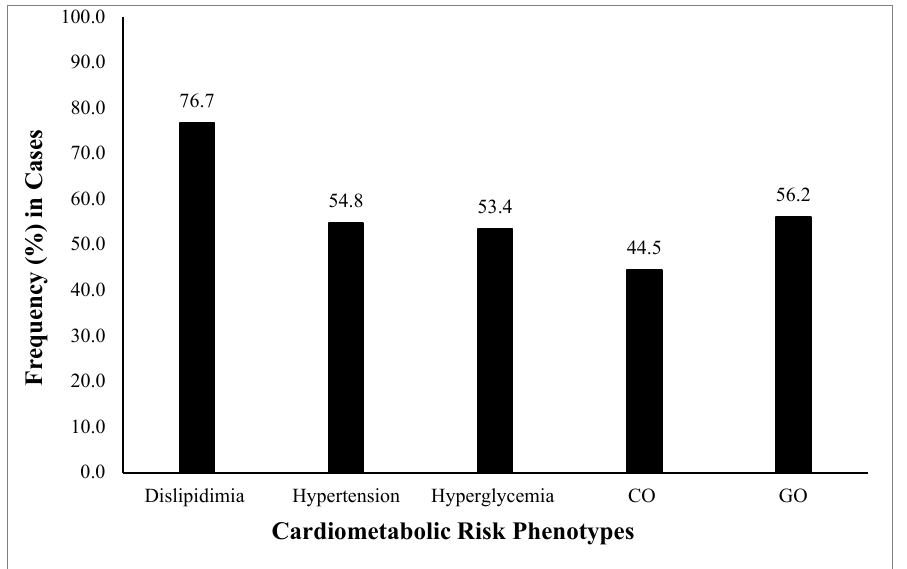
Figure 1. Frequency (%) of cardiometabolic risk phenotypes among the studied population. The cardiometabolic risk phenotypes presented are general obesity or GO (BMI ≥ 30 Kg/m 2 ), central obesity or CO (WHR > 0.90 for males and 0.85 for females), hypertension (SBP > 139 mmHg and DBP > 89 mmHg) (34), hyperglycemia (FBG > 100 mg/dL), and dyslipidemia (LDL > 100 mg/dL, HDL < 40 mg/dL and TG > 150 mg/dL). The highest observed frequency was of dyslipidemia followed by GO, hypertension, hyperglycemia, and CO. GO, general obesity; CO, central obesity; BMI, body mass index; WHR, waist-to-hip ratio; SBP, systolic blood pressure; DBP, diastolic blood pressure; FBG, fasting blood glucose; LDL, low-density lipoprotein; HDL, high-density lipoprotein; TG,